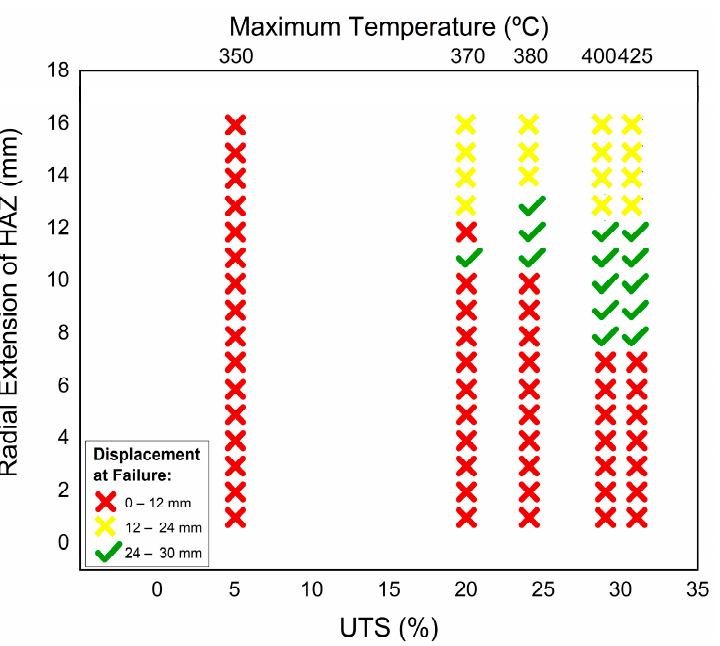
Figure 13. Compilation of all evaluated THTB simulated models and qualification of drawing depth based on material softening degree and HAZ dimension.